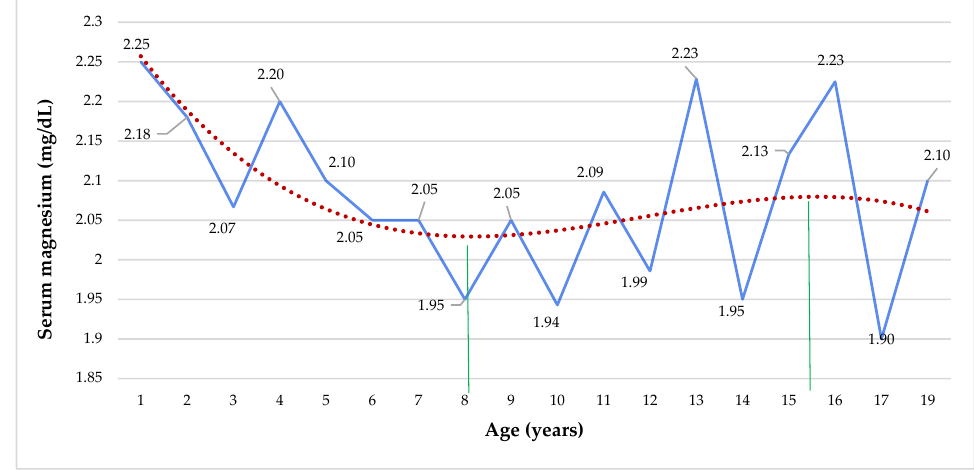
Figure 2. Least Square Means serum magnesium (mg/dL) for factor age (years).